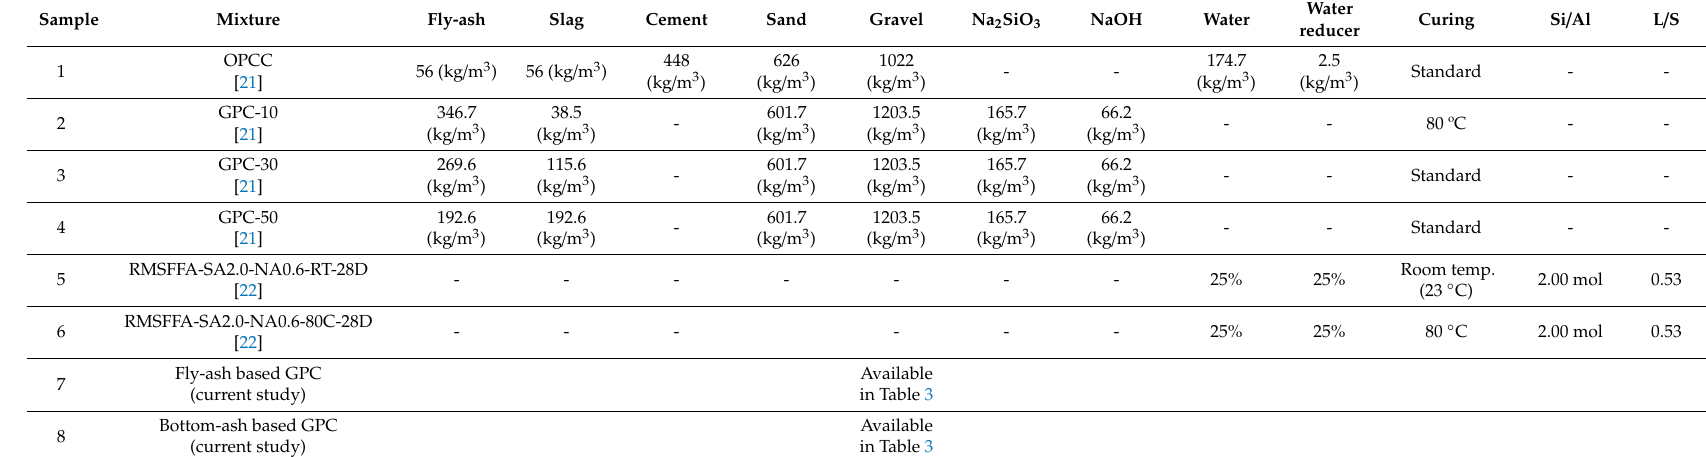
Table 4. Comparison of mix